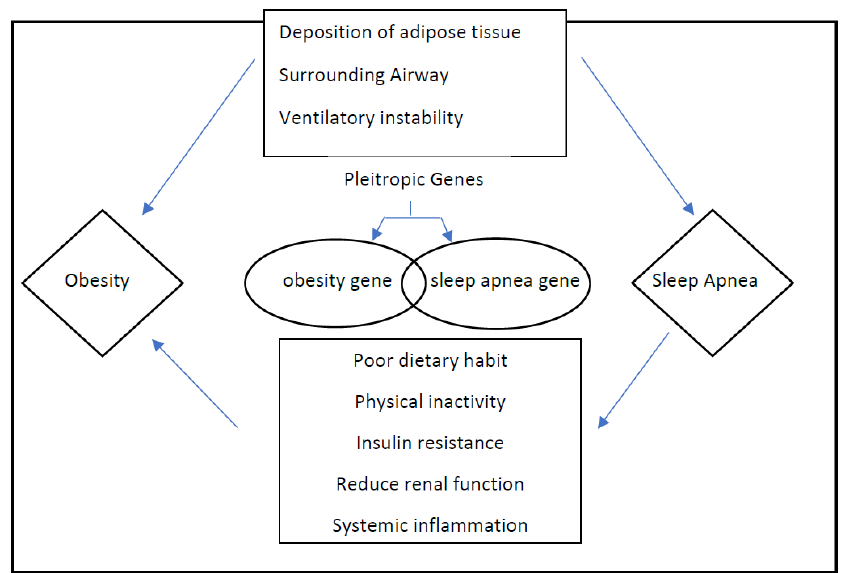
Figure 1. Proposed mechanisms acting as a vicious cycle in the pathogenesis of obstructive sleep apnea and obesity and the potential influences of shared and non-shared genes.